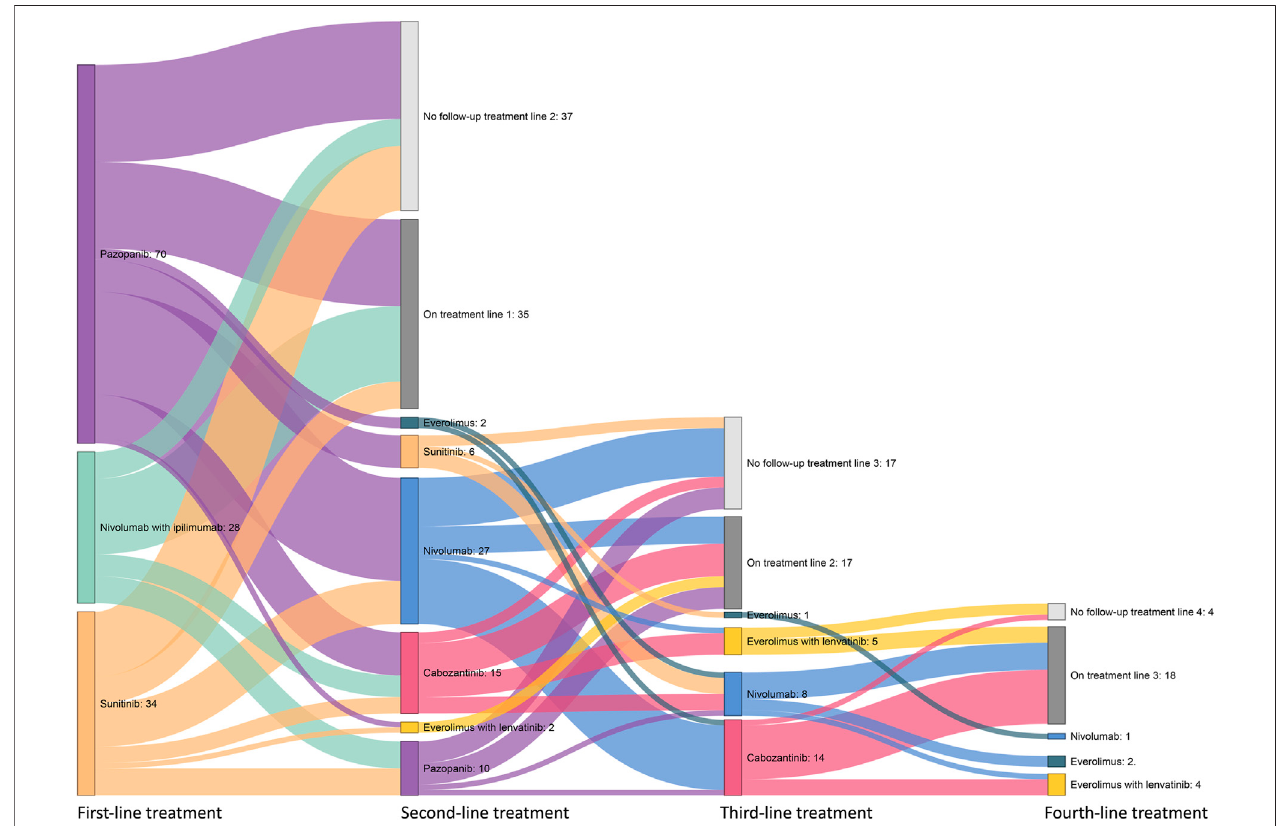
FIGURE 3 | Overview of systemic drug treatment patterns following patients who received fi rst-line pazopanib, sunitinib, or nivolumab with ipilimumab treatment.